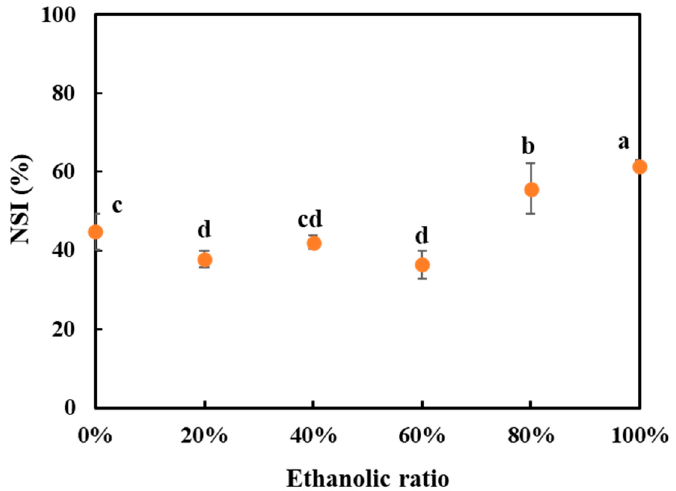
Figure 7. The nitrogen solubility index (NSI) of all the soy protein concentrates (SPCs). The values in the figure are compared and different top letters (a,b,c,d,e) indicate a significant difference ( p < 0.05).